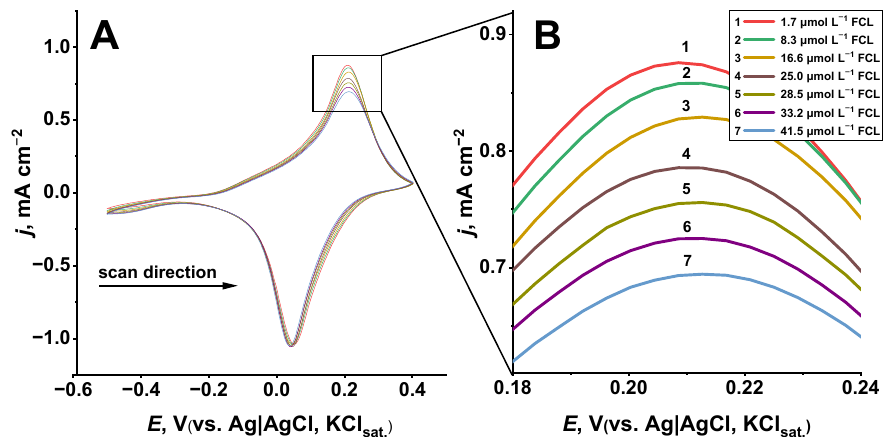
Figure 2. ( A ): CV curves of the glass|FTO|PB sensor registered in PBS containing different concentrations of FCL. ( B) : magnified data representing anodic current peaks ( A ) of the glass|FTO|PB sensor. Potential scan rate: 40 mV s − 1 .